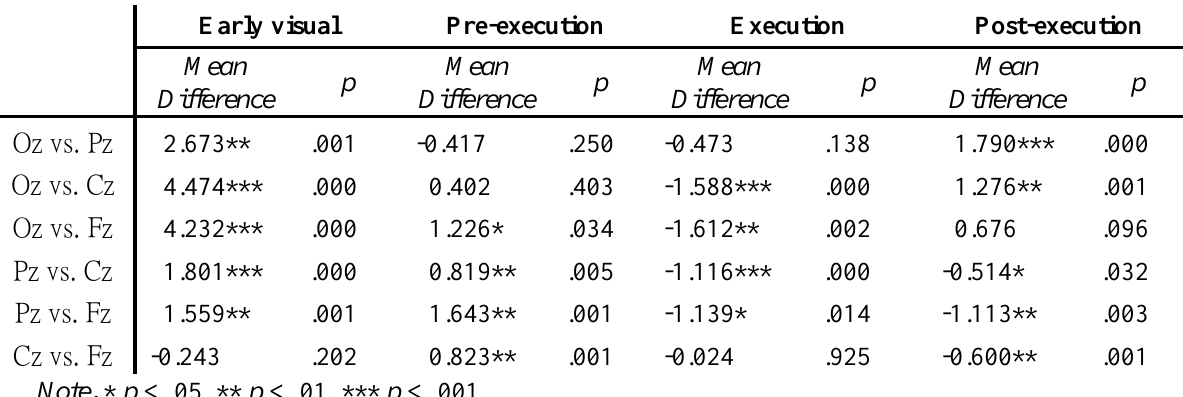
Table 2. LSD post hoc tests to compare the differences of mean amplitudes between the pairs of electrodes on the midline during the four